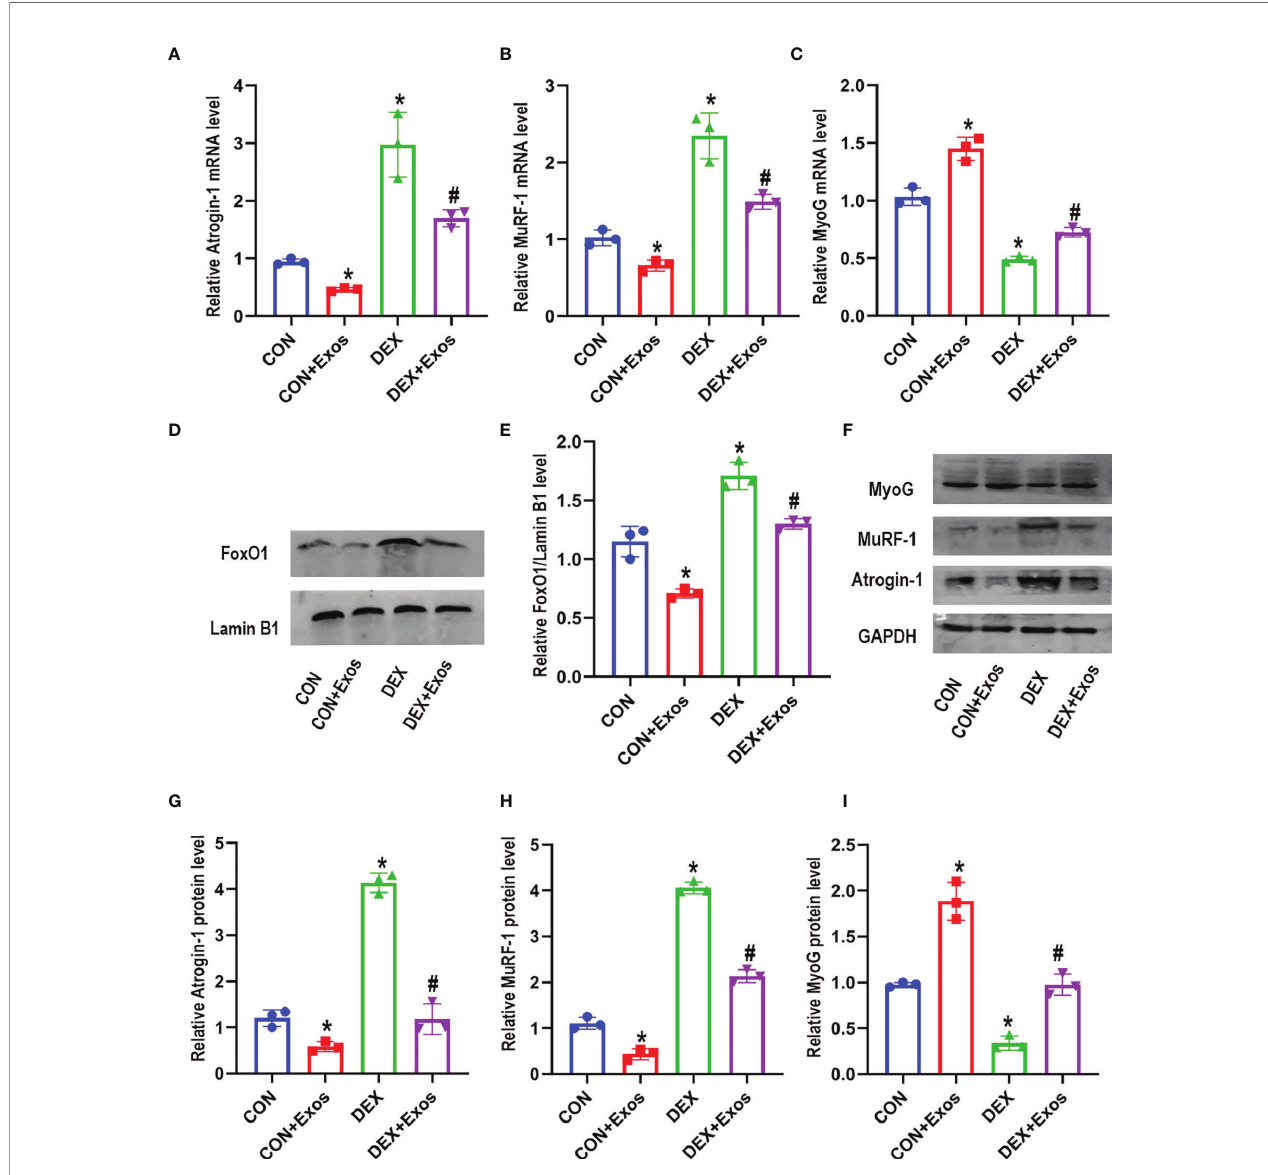
FIGURE 3 | Exosomes derived from BMSCs regulated mRNA andproteinexpression involved inmuscleatrophy andmyogenesis. (A) Measurements ofAtrogin-1 mRNA expression in different groups(n= 3). (B) Measurements of MuRF-1 mRNA expression indifferent groups(n = 3). (C) Measurements of MyoG mRNA expression indifferent groups (n= 3). (D,E) The proteinlevel of FoxO1 innuclear was measured by Westernblot analysis (n = 3). LaminB1 was used as the internal reference. (F – I) Measurements of Atrogin-1, MuRF1and MyoG protein levelin indifferent groups (n = 3).*p < 0.05 compared to the control group. # p < 0.05 compared to the DEX